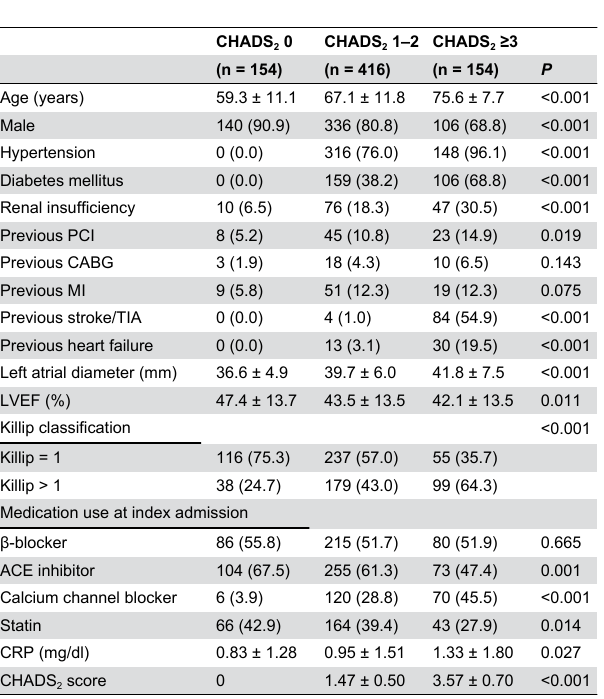
Table 1. Baseline characteristics of patients according to CHADS scores. 2